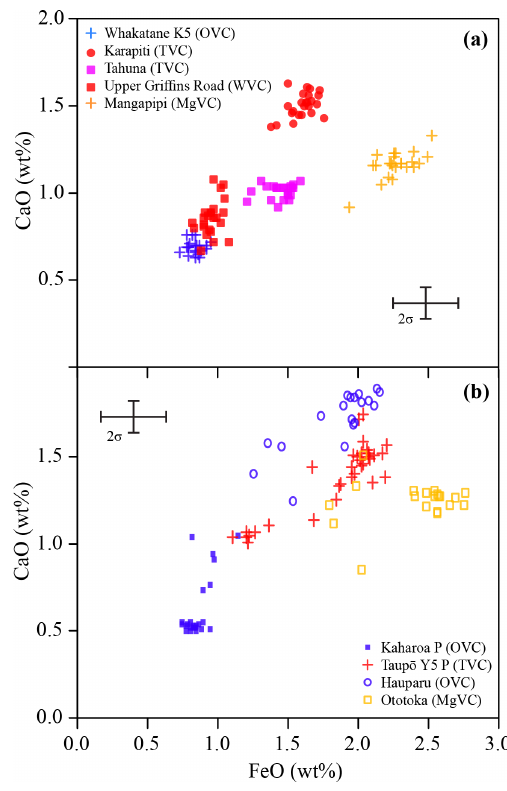
Figure 5. Examples of major-element bivariate plots for glass- shard analyses of tephras (presented on a normalised basis) which show (a) homogeneous signatures, where the standard deviation of the analysis is less than the analytical error (shown as 2 σ ), and (b) heterogeneous signatures, where the standard deviation of the anal- ysis is greater than the analytical error. Different colours indicate the differing caldera sources (shown in Fig. 1), and different sym- bols show the different tephras. P – proximal sample (see Table 1). Total iron is expressed as